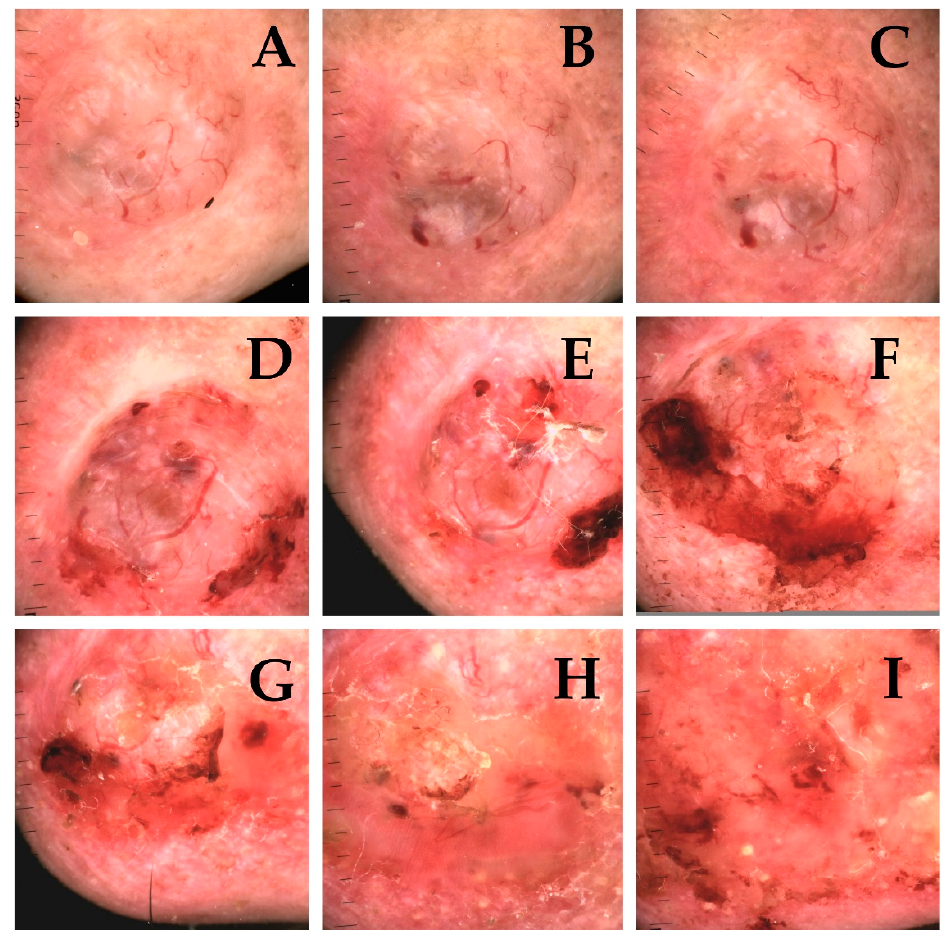
Figure 7. Dermoscopic image of basal cell carcinoma of the nose, nodular type, of 83-year-old patient (clinically presented in Figure 4). ( A )—tumour prior to brachytherapy (t1), exhibit the presence of multiple white structures including: perpendicular white lines, structureless white zones, white shiny clods, accompanied by multiple polymorphous vessels (serpentine, in branched arrangement), with addition of blue, small clods. ( B , C )—During the consecutive treatment fractions (t2–t3) mentioned structures remain visible. ( D – I ) Development of necrosis of the tumour (t4–t9) leads to gradual disappearance of dermoscopic structures with formation of ulceration.